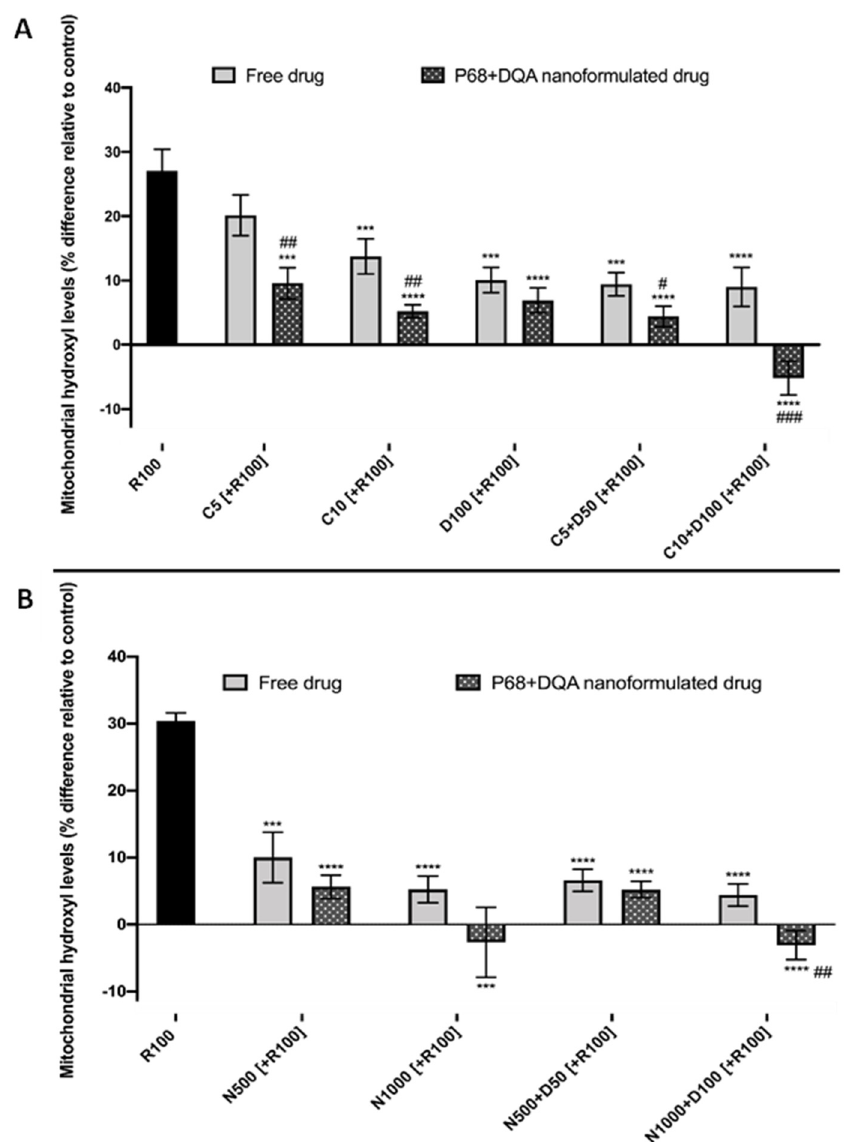
Figure 8. ( A ) SH-SY5Y mitochondrial hydroxyl radical assay results for free and P68 + DQA prepa- rations of 5 and 10 µ M curcumin, 100 µ M DFO or combined curcumin and DFO (5 or 10 µ M curcumin + 50 or 100 µ M DFO, respectively) following passage across the hCMEC/D3—SH-SY5Y co-culture Transwell ® system. The hCMEC/D3 cells were grown on the insert and the SH-SY5Y cells were located at the bottom of the basolateral compartment. Treatments were added to the apical compartment of the Transwell ® system and incubated for 3 h, the SH-SY5Y cells were then incubated with 100 µ M rotenone for 24 h. These results were compared to rotenone treatment alone. Mitochondrial hydroxyl radical levels are expressed as the percentage of hydroxyl radical identified in control cells (SH-SY5Y cells treated with MEM media only, for 24 h). (mean ± S.D., n = 6). ( B ) Corresponding mitochondrial hydroxyl radical assay results for free and P68 + DQA preparations of 500 and 1000 µ M NAC and combined NAC and DF0 (500 or 1000 µ M NAC + 50 or 100 µ M DFO, respectively). * represents significance values of control or pre-treatment conditions compared to rotenone treatment alone (**** p < 0.0001, *** p < 0.001). # represents significance values of nanoformulated drug compared to free drug within the same treatment condition (### p < 0.001, ## p < 0.01, # p <